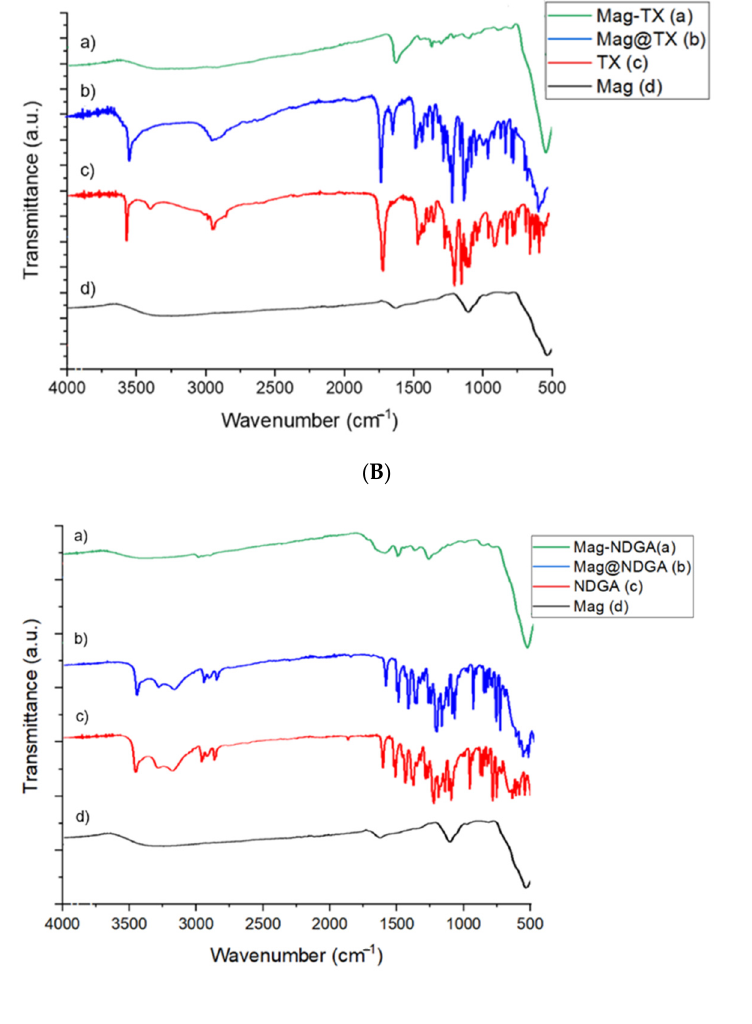
Figure 1. Panels ( A – C ): FT-IR spectra of the investigated materials obtained from gallic acid ( A ), Trolox ( B ) and nordihydroguaiaretic acid ( C ).